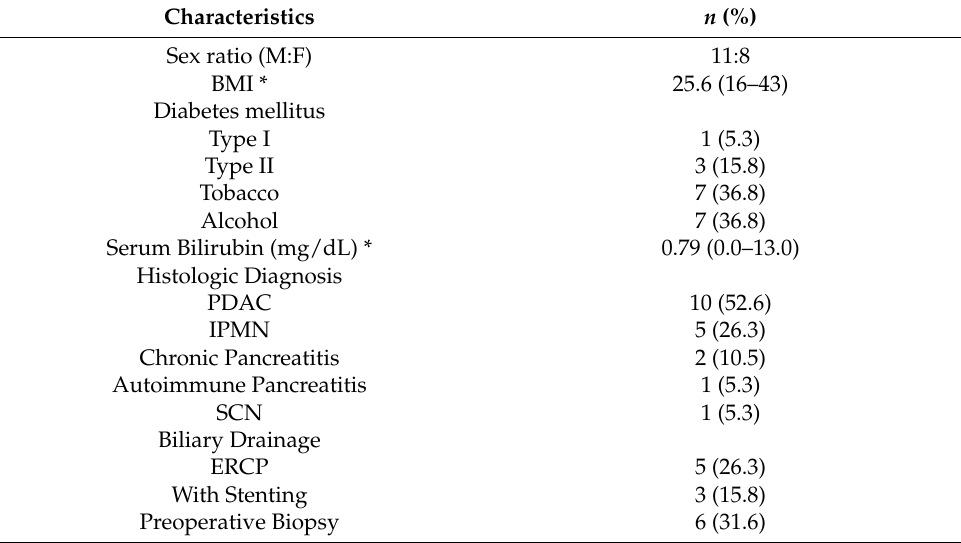
Table 1. Patients’ data of the specimens included in this